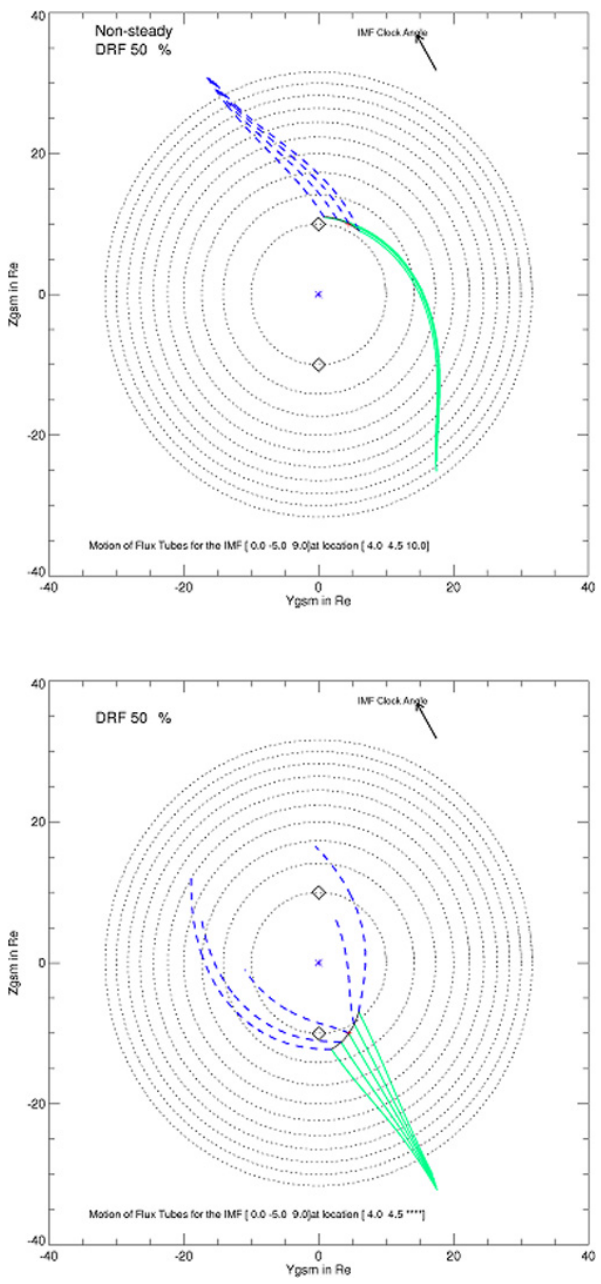
Fig. 8. Output of the Cooling model for a IMF of (0, 5, 9)nT in GSM, corresponding to the prevailing IMF when SC1 crosses he cusp, and for a reconnection site poleward of the northern cusp (top) and poleward of the southern cusp (bottom). The blue dashed and green solid lines show the path of newly-reconnected field lines from the X-line (black solid